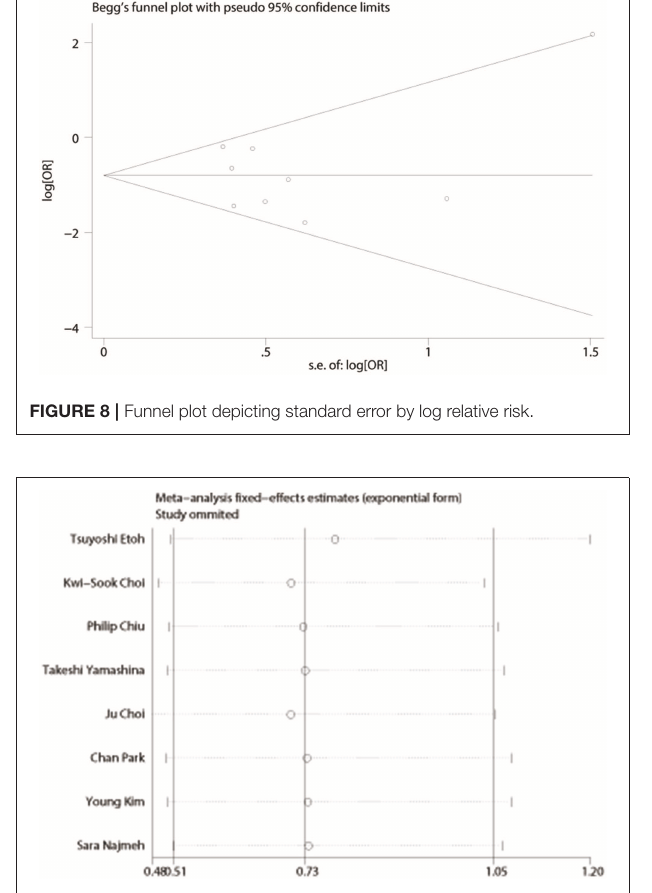
diameter. (c) of undifferentiated-type, UL( − ), and ≤ 2 cm in